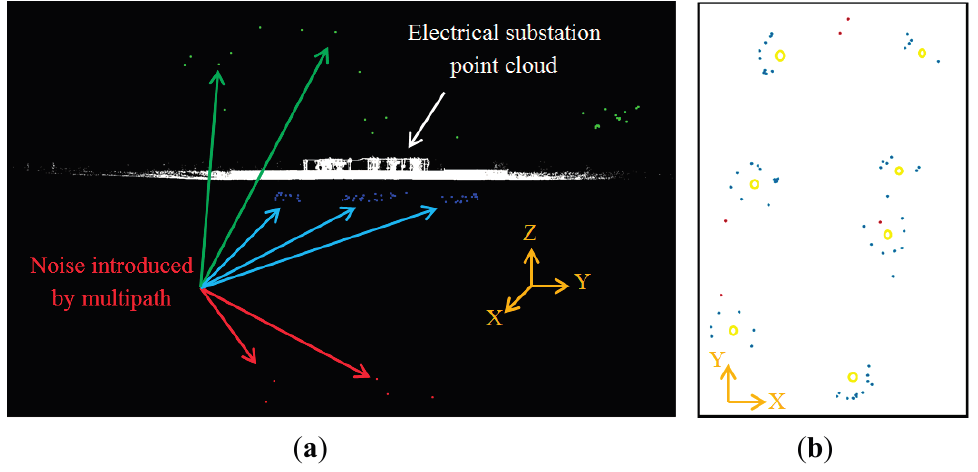
Figure 17. Multipath-introduced noise is indicated by red, blue and green colors based on their height ( a ). Noise follows a circular pattern around the instrument tripod locations (plan view). Small yellow circles represent the instrument’s locations during scan time ( b